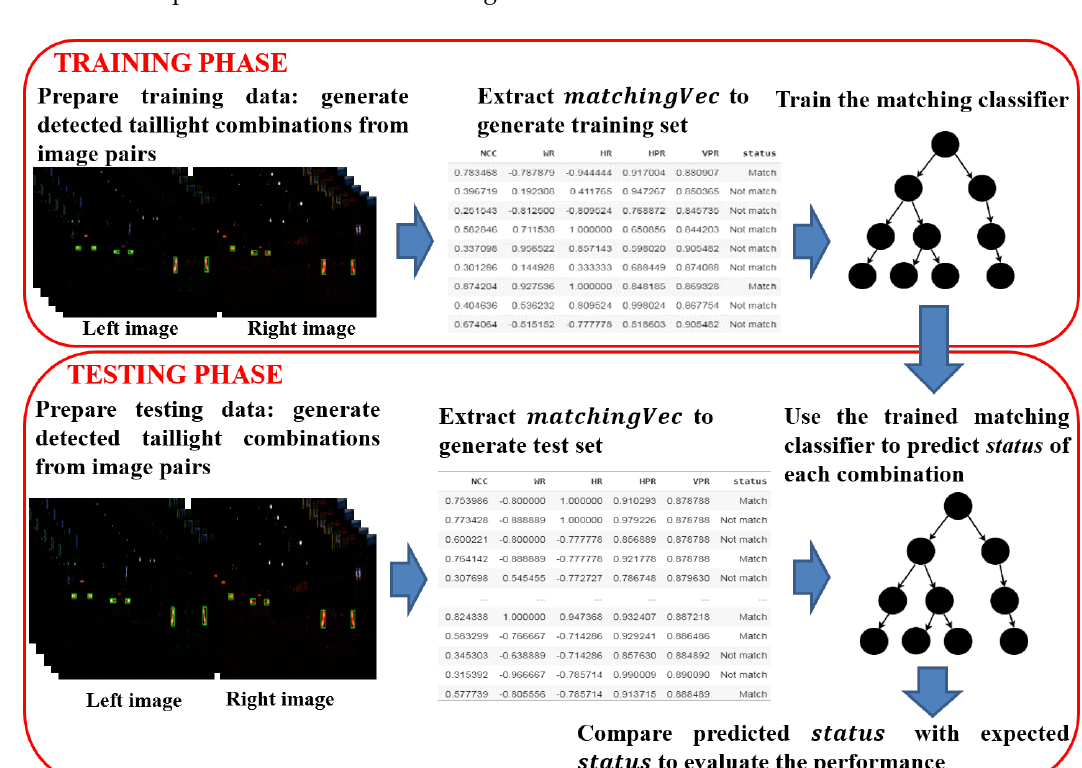
Figure 26. Constructing datasets for training and testing